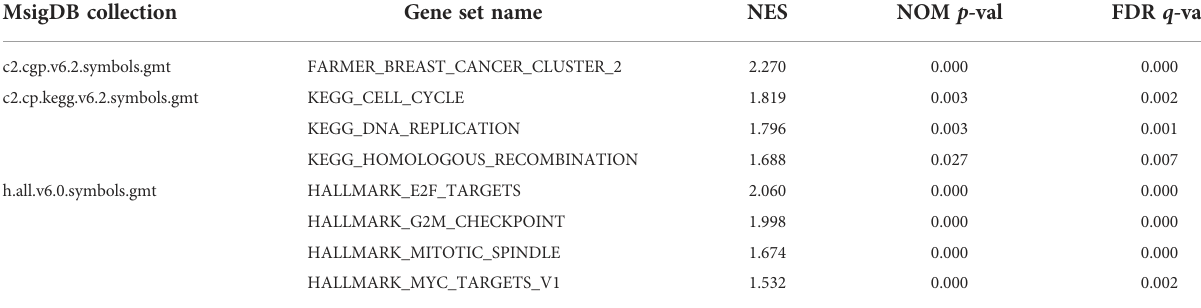
TABLE 3 Gene set enriched with SNORA38 high expression.